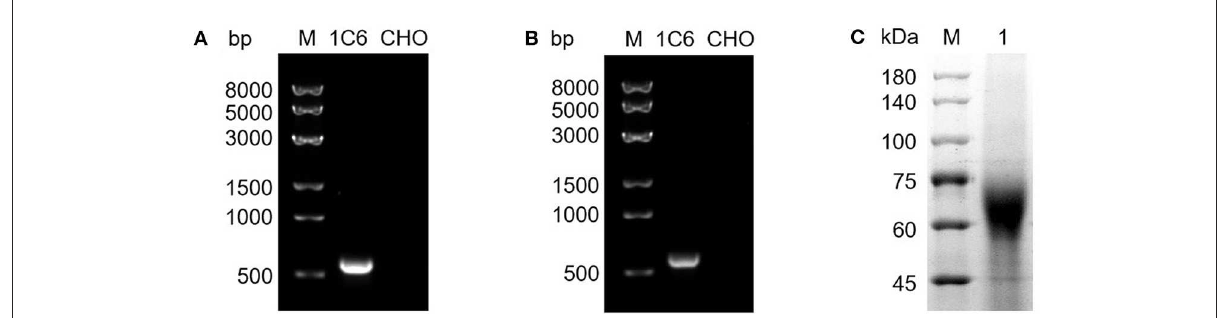
FIGURE2 Genomic verification and protein purification of a high-expression CHO-CD2v cell line. The total genomic DNA and RNA of 1C6 cell line were extracted from the 1C6 cell line and the presence of the CD2v-ex at the genomic DNA and mRNA levels confirmed by PCR (A) and RT-PCR (B) analyses, respectively; blank CHO-S cells were treated as a negative control. SDS-PAGE analysis of purified CD2v-ex protein (C) .